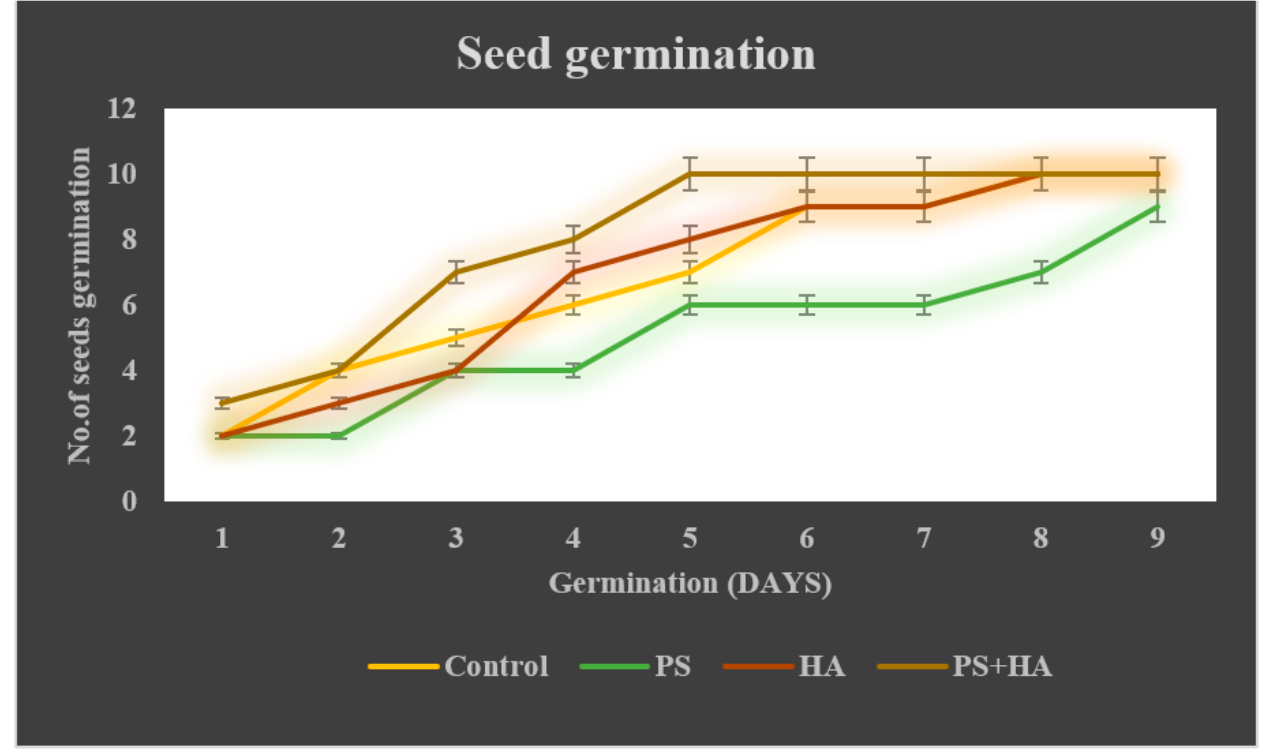
Figure 5. This line graph shows the Seed germination in PS, HA, and PS + HA. 3.3. Effect of PS, HA, and PS + HA on Solanum lycopersicum (Plants) On the ninth day, the average shoot and length of the plants of the control group were 5 cm and 14.7 cm, respectively. On the contrary, the PS-treated group showed shoot and root lengths of 3 cm and 9.4 cm, respectively. The HA-treated set showed shoot and root lengths of 7.3 cm and 16.2 cm, respectively. On the other hand, the PS + HA complex has a shoot and root length (Figure 6A,B) of 6.3 cm and 15.3 cm for the shoot and root length, respectively. The maximum shoot and root length were observed in the HA and PS + HA-treated groups (Figure